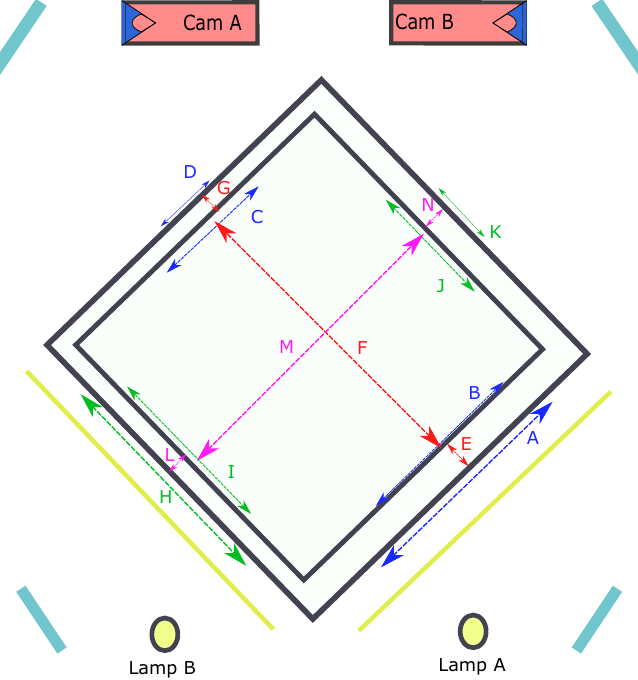
Figure 2. A top-down cartoon displaying the measurements characterizing the optical field of view for each 2DVD. Light rays traverse through the interior of the instrument diagonally, traveling from each lamp to the adjacent (light blue) mirror, propagating through the (yellow) Fresnel lens and (through slits in a metal frame) into the interior of the measurement area. The light then propagates through slits on the other side of the measurement area to the mirror next to the associated camera. All labeled distances in the figure were carefully measured at the field site. If the pixels in the field of view really would be of uniform size, then the distances marked A, B, C, and D would all be the same length (as would H, I, J, and K). Actual measurements for both 2DVDs used in this study are shown in Table 1. After the light from the illumination source passes through the Fresnel lenses, there are no optical elements between the light source and the camera except for a single flat mirror. Because of